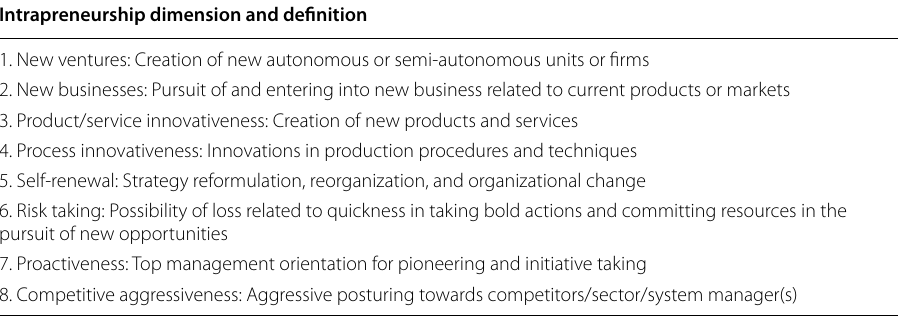
Table 1 Eight dimensions of intrapreneurship, adapted from Antoncic and Hisrich